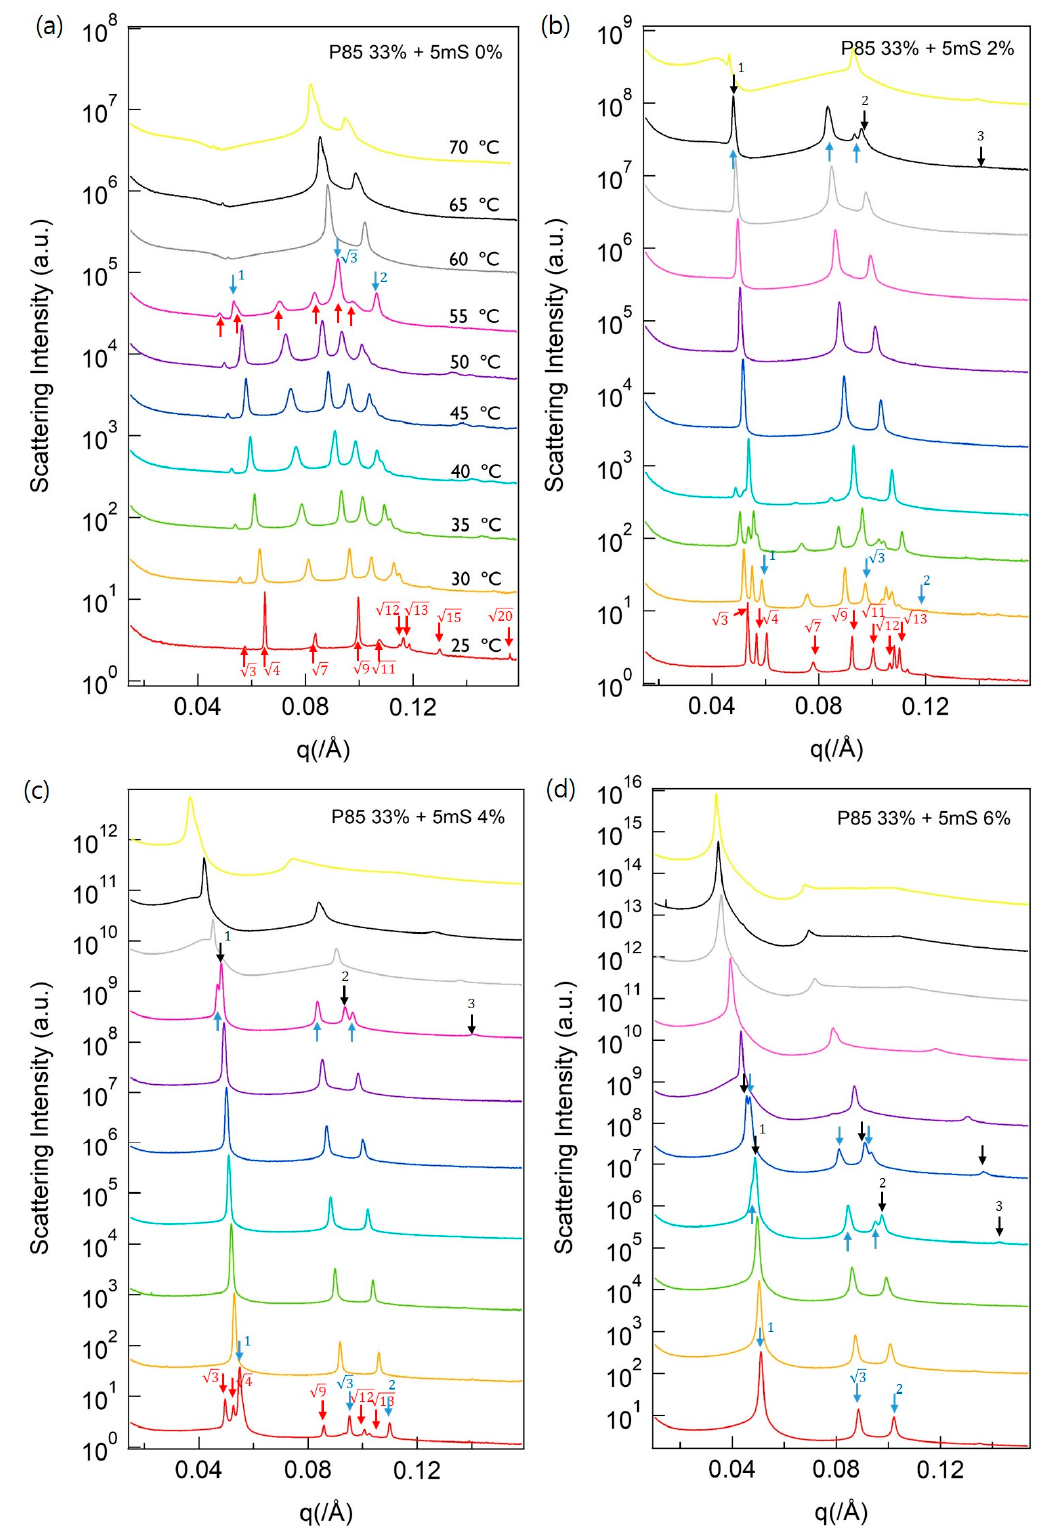
Figure 3. SAXS intensities of the P85-5mS complex in aqueous solution. ( a ) P85 35%-5mS 0.0 %, ( b ) P85 35%-5mS 2.0 %, ( c ) P85 35%-5mS 4.0 %, and ( d ) P85 35%-5mS 6.0 % were conducted depending on a various temperature. The red, light blue, and black arrows indicate the SAXS signals of the FCC, hexagonal, and lamellar phases, respectively.